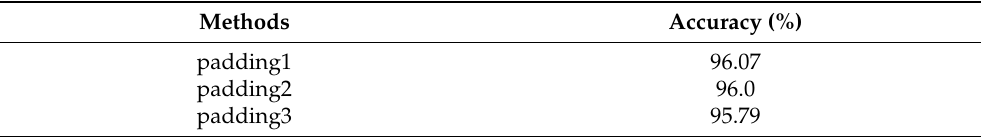
Figure 7. The recognition accuracy of different zero-pad methods on the IAHCC-UCAS2016 varies with the training epoch. Table 2. Accuracy of different padding methods on the IAHCC-UCAS2016